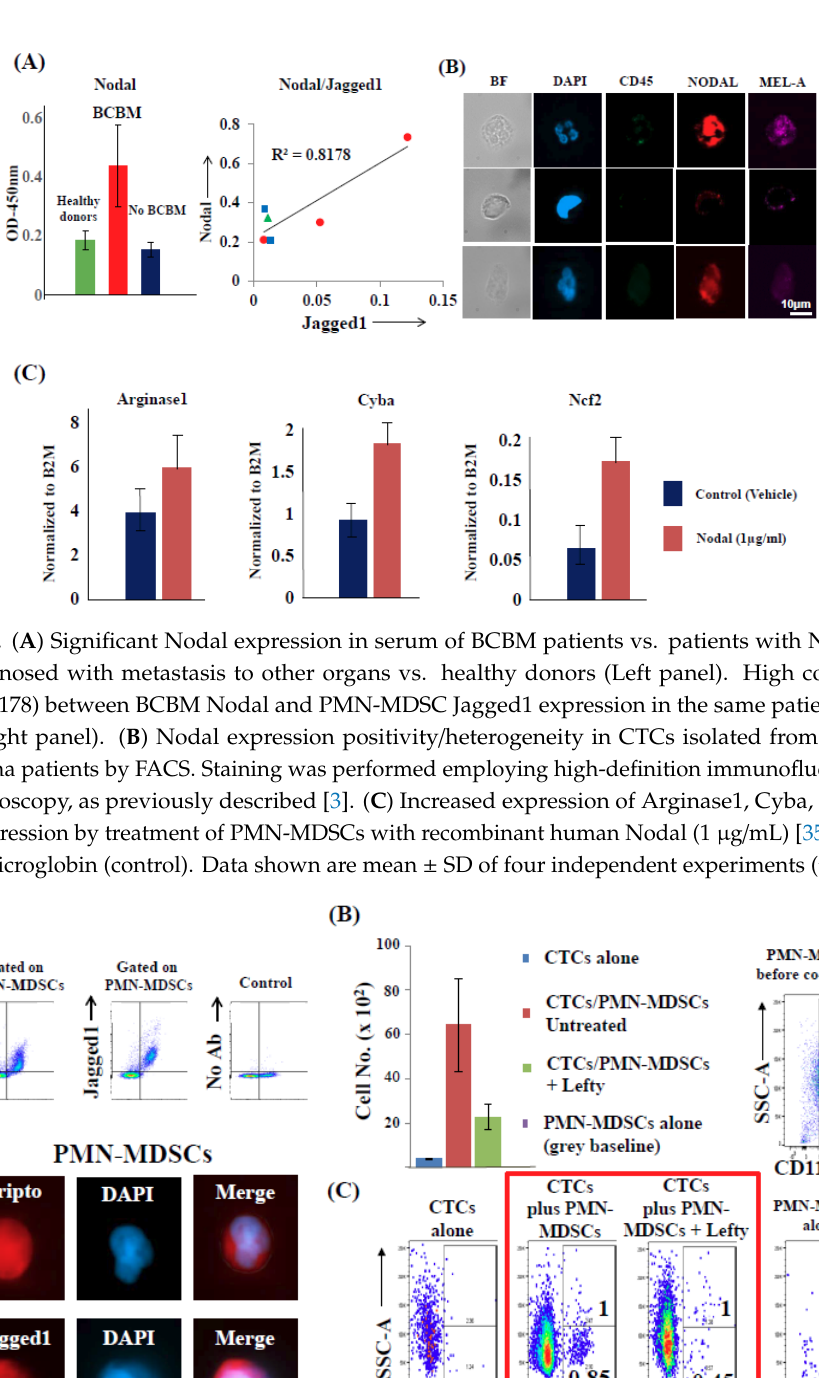
Figure 9. ( A ) Detection of Cripto/Jagged1 over-expression in PMN-MDSCs isolated from blood of BCBM patients by FACS followed by high-definition immunofluorescence (IF) microscopy. Single-